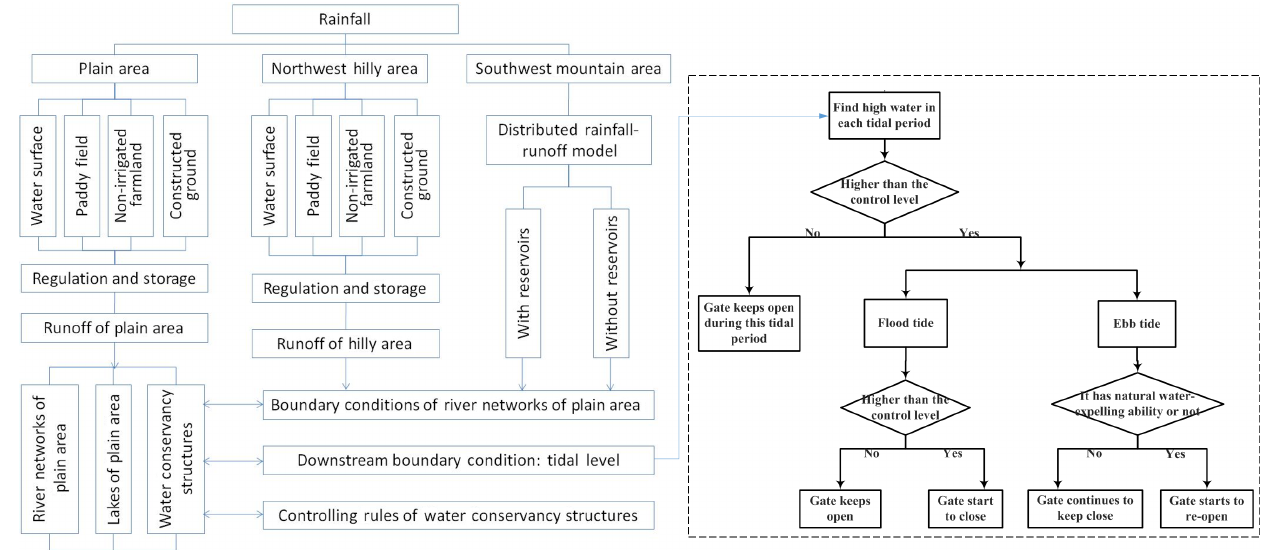
Figure 2. Schematization of the extended HOHY model (modified from Jin et al.,